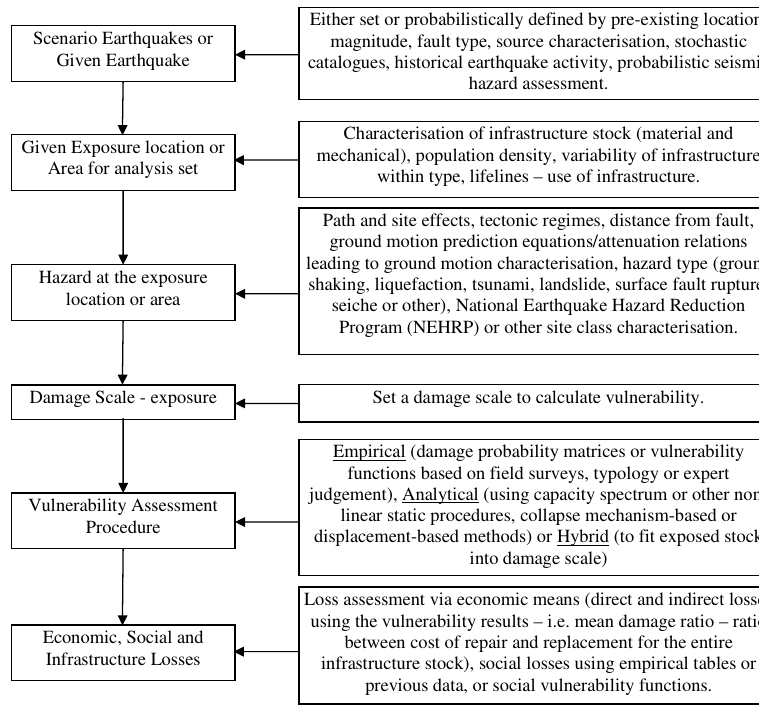
Fig. 2. Flowchart of identified components of an Earthquake Loss Assessment (ELA) (Rapid-Response, Post- or Figure 2. Flowchart of Identified Components of an Earthquake Loss Assessment (Rapid-3 Response, Post- or Pre-Earthquake). 4